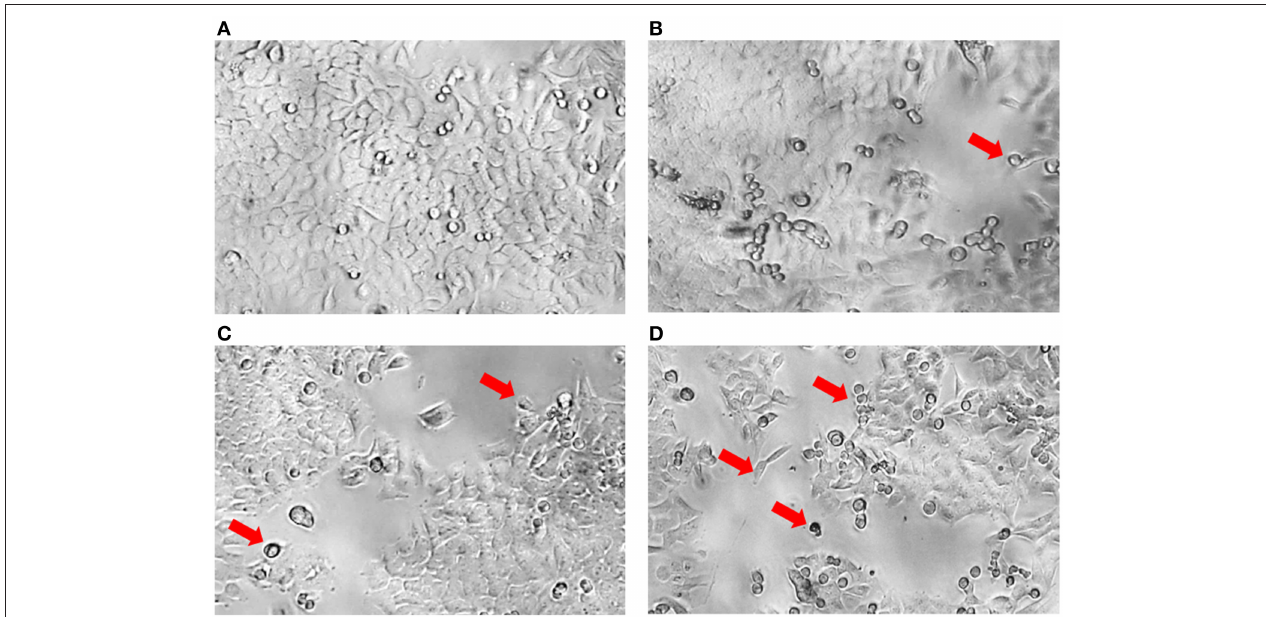
FIGURE 4 | Morphology of HCT116 after treatment with MUM256 extract at different concentrations. Comparison of the morphological features of HCT116 after the 72h with MUM256 extract at respective concentrations [control (A) , 100 µ g/mL (B) , 200 µ g/mL (C) , 400 µ g/mL (D) ] observed under an inverted microscope with objective lens x40. Arrow indicates the abnormal morphological features resulted from the anticancer effect of MUM256